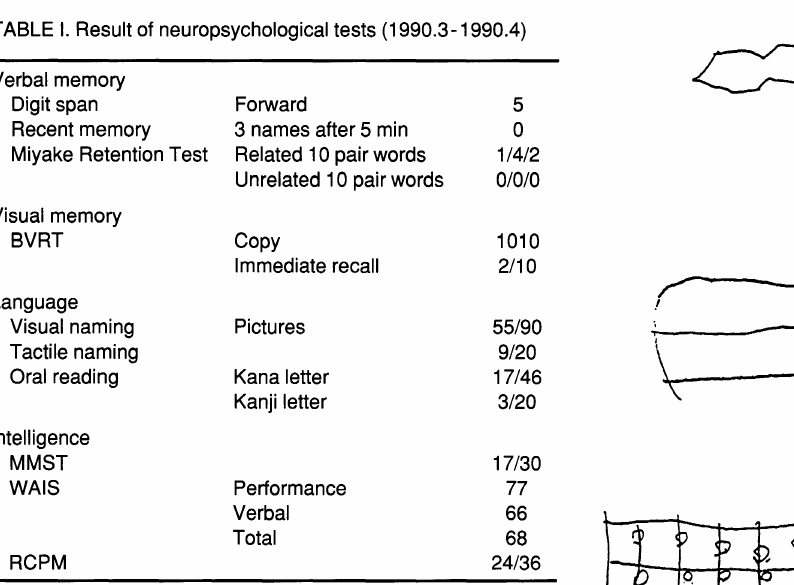
TABLE I. Result of neuropsychological tests (1990.3 -1990.4)